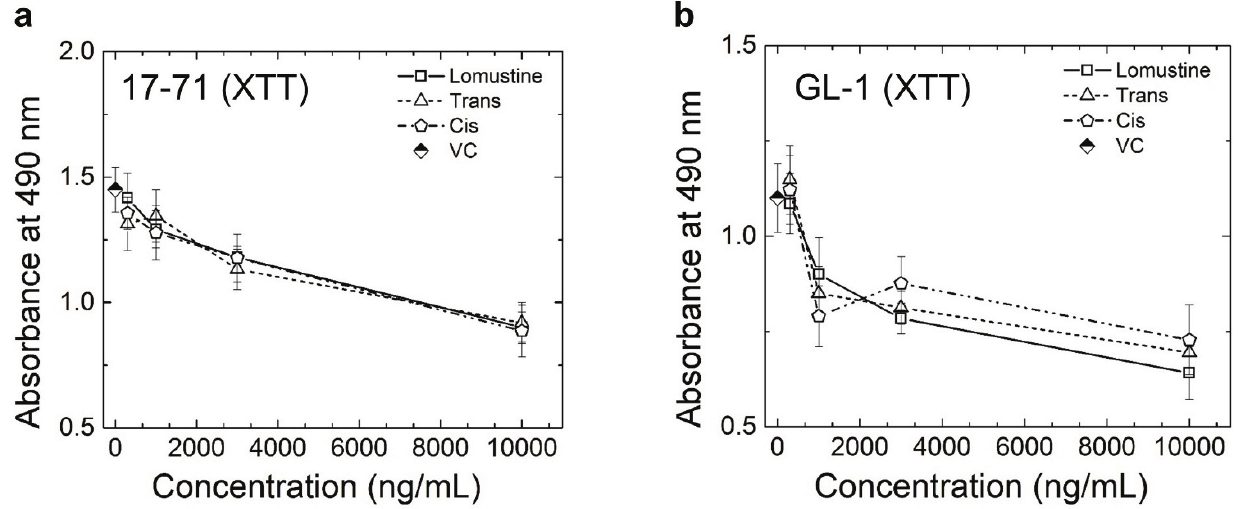
Figure 3. Graphs showing the results of XTT assay in 17–71 ( a ) and GL-1 ( b ) cells at 48 h. Vehicle control (VC) was 0.1% methanol. The results show the mean and standard deviation of three independent experiments (n = 3).